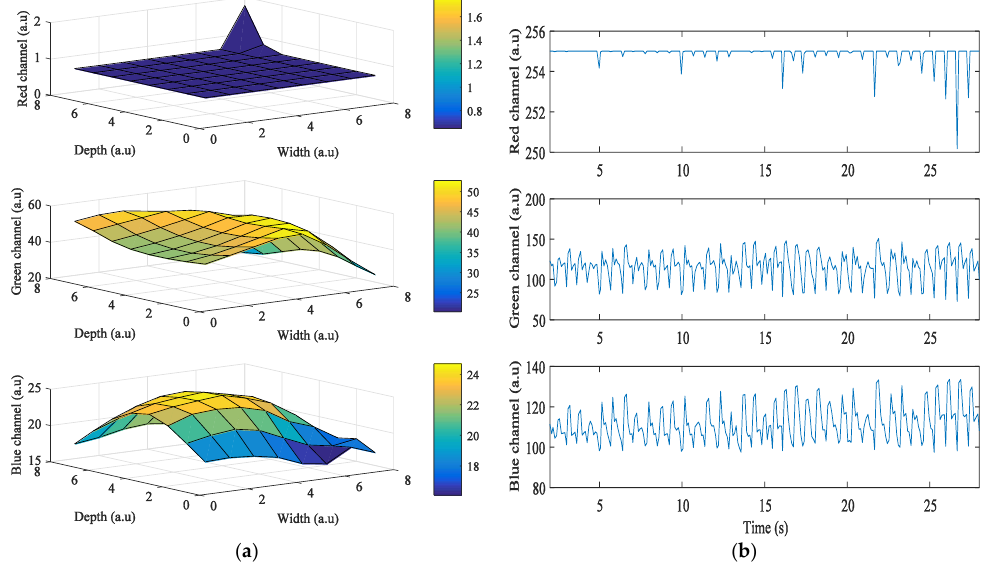
Figure 3. Example of quality analysis of PPG signals obtained from a subject using the HTC One M8: ( a ) intensity change distribution; ( b ) intensity of PPG signal.